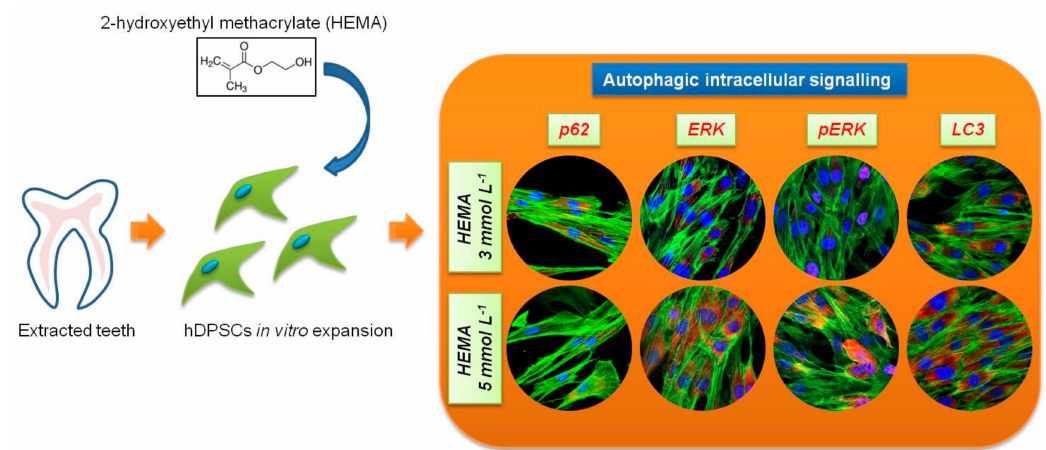
Figure 1. Schematic view of the experimental design. hDPSCs, human Dental Pulp Stem